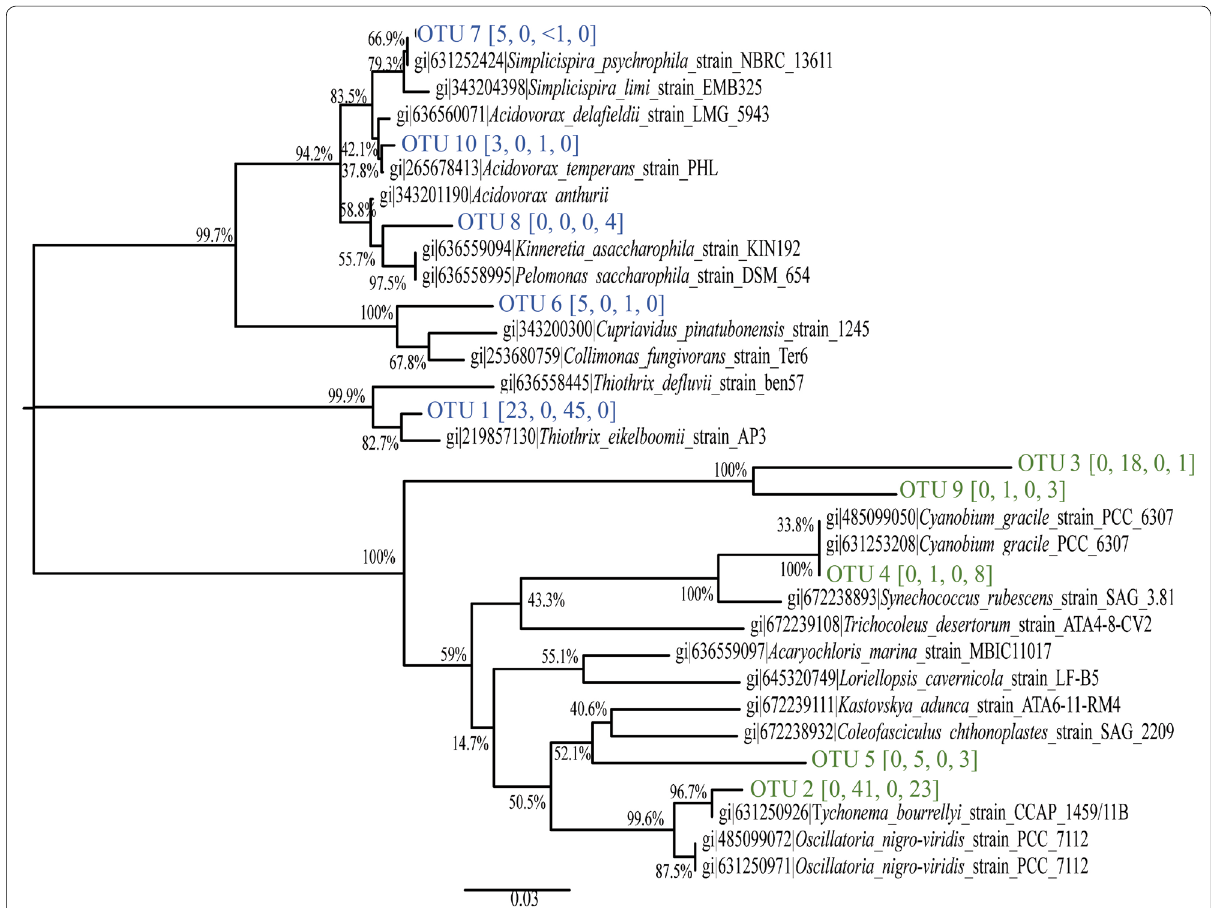
Fig. 4 Phylogenic tree of the ten most abundant OTUs found in the initial (t unsuccessful cultivation of OPGs. Blue associated with bacteria. Green associated with cyanobacteria [% succ., 0 day; % succ, 42 days; %unsucc 0 day, % unsucc, 42